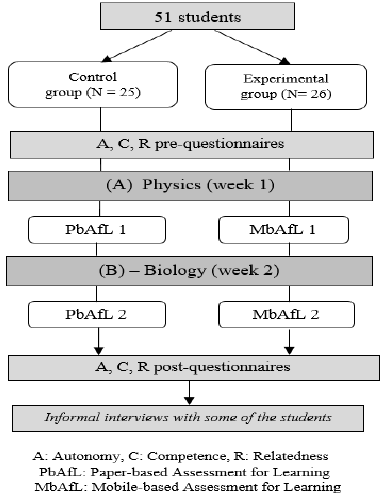
Figure 4. The experimental procedure.